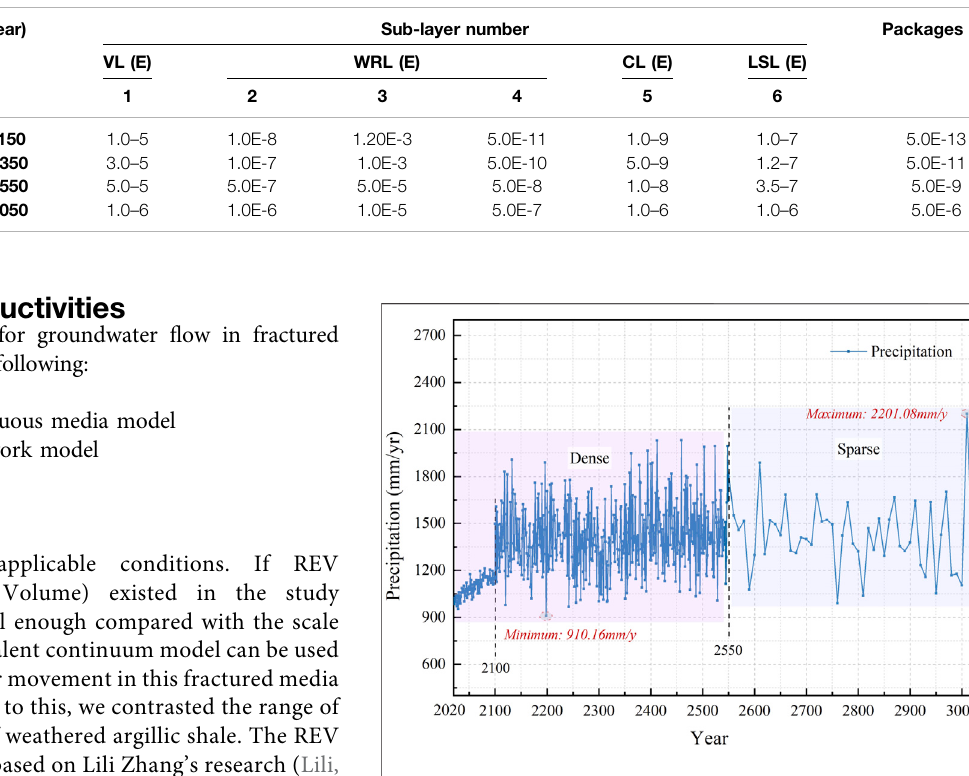
FIGURE 5 | Predicted precipitation curve in Rcps4.5 (Low GHG emissions condition of Representative Concentration Pathway Climate Scenario) by Institute of Earth Environment, Chinese Academy of